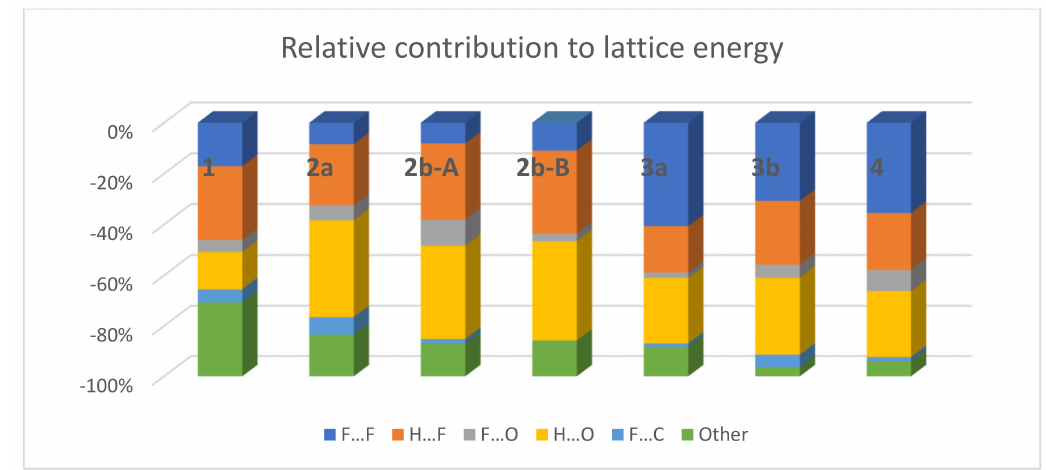
Figure 14. Relative contribution of various intermolecular interactions to lattice energy according QTAIM / EML.